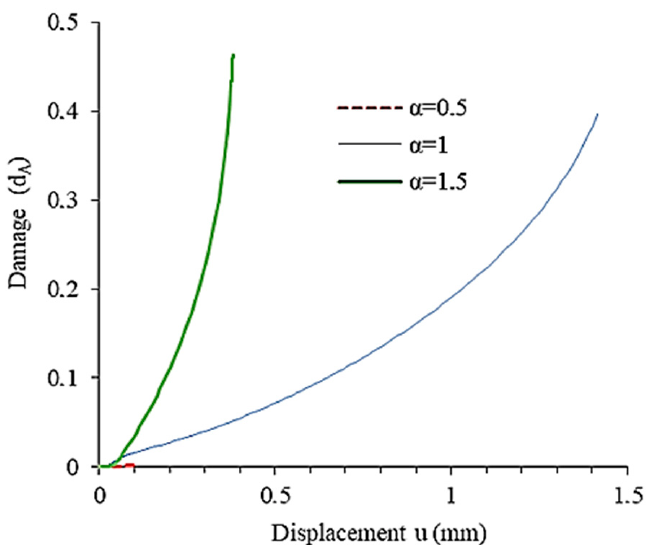
u curves. Figure 2. d A versus u curves.